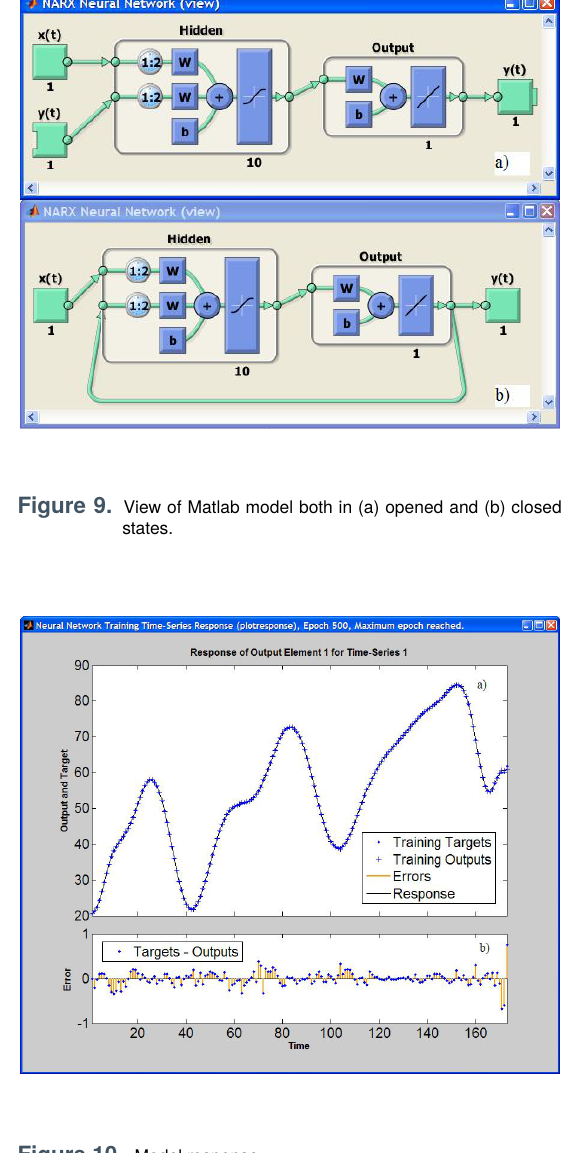
Figure 10. Model